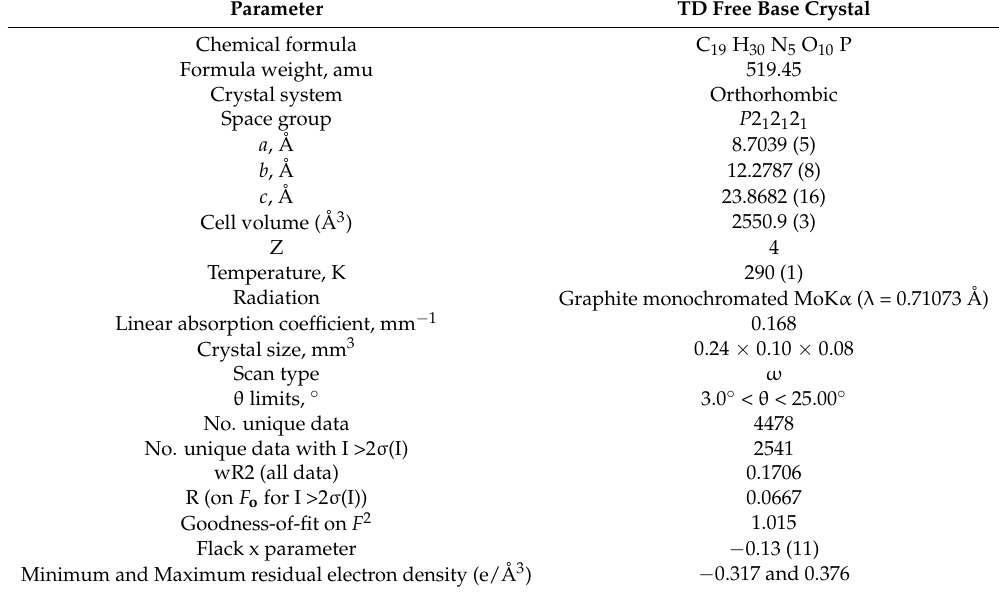
Table 2. Crystal data and structure refinement for the Tenofovir disoproxil (TD) free base.